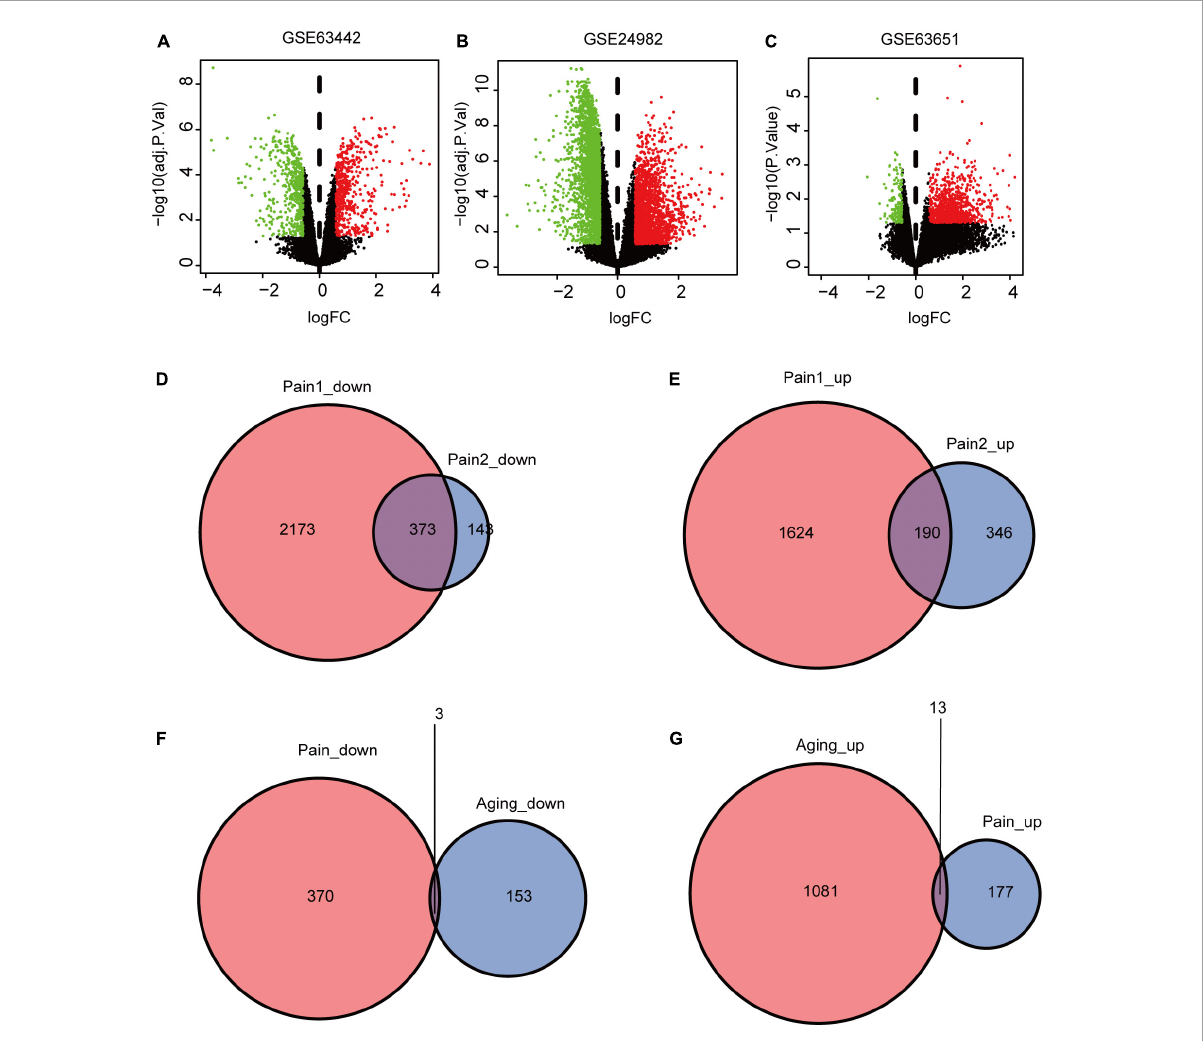
FIGURE2 DEGs and co-DEGs identification. (A–C) The volcano plots of pain1: GSE63442, pain2: GSE24982 and aging: GSE63651. (D,E) The two pain datasets showed an overlap of 373 down-regulated DEGs and 190 upregulated DEGs. (F,G) The two neuropathic pain and aging datasets showed an overlap of 16 co-DEGs (3 down-regulated and 13 upregulated). DEGs, differential expressed genes; co-DEGs, common differential expressed